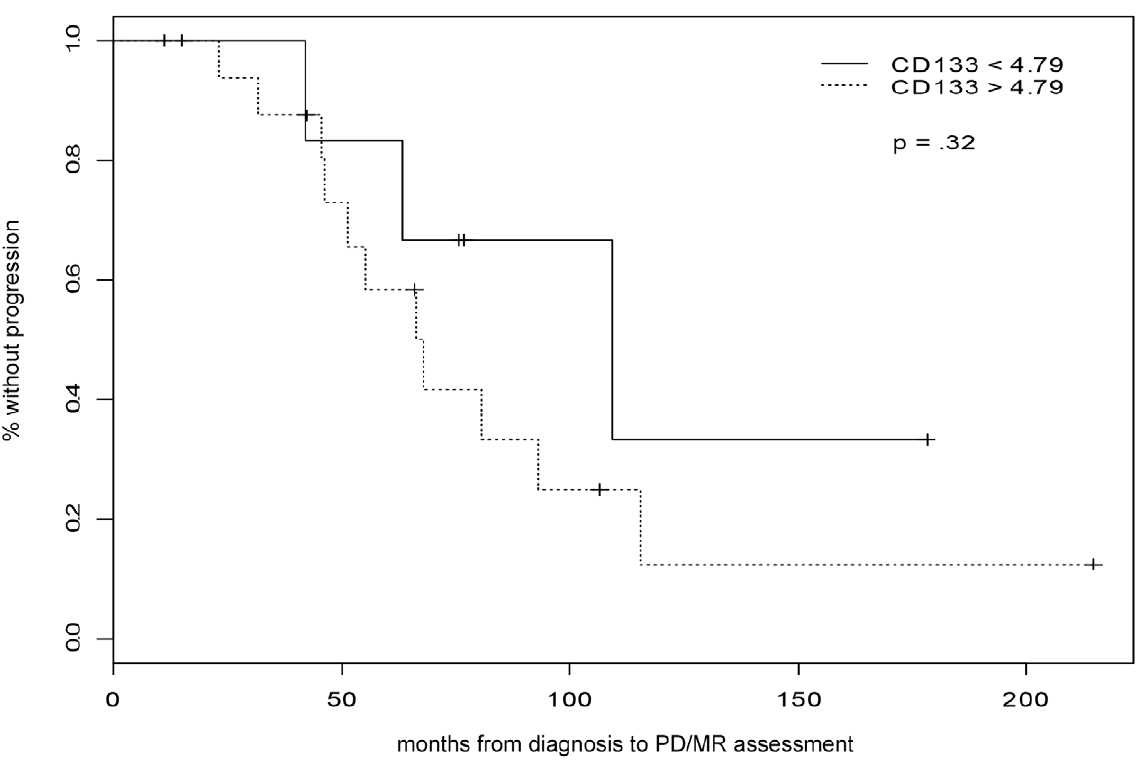
Figure 2. Kaplan Mier progression free survival versus CD133 mRNA cutoff points of 4.79. There was a trend that patients with CD133 mRNA level higher than 4.79 had worse outcome, however the statistical significance was not reached due to the small sample